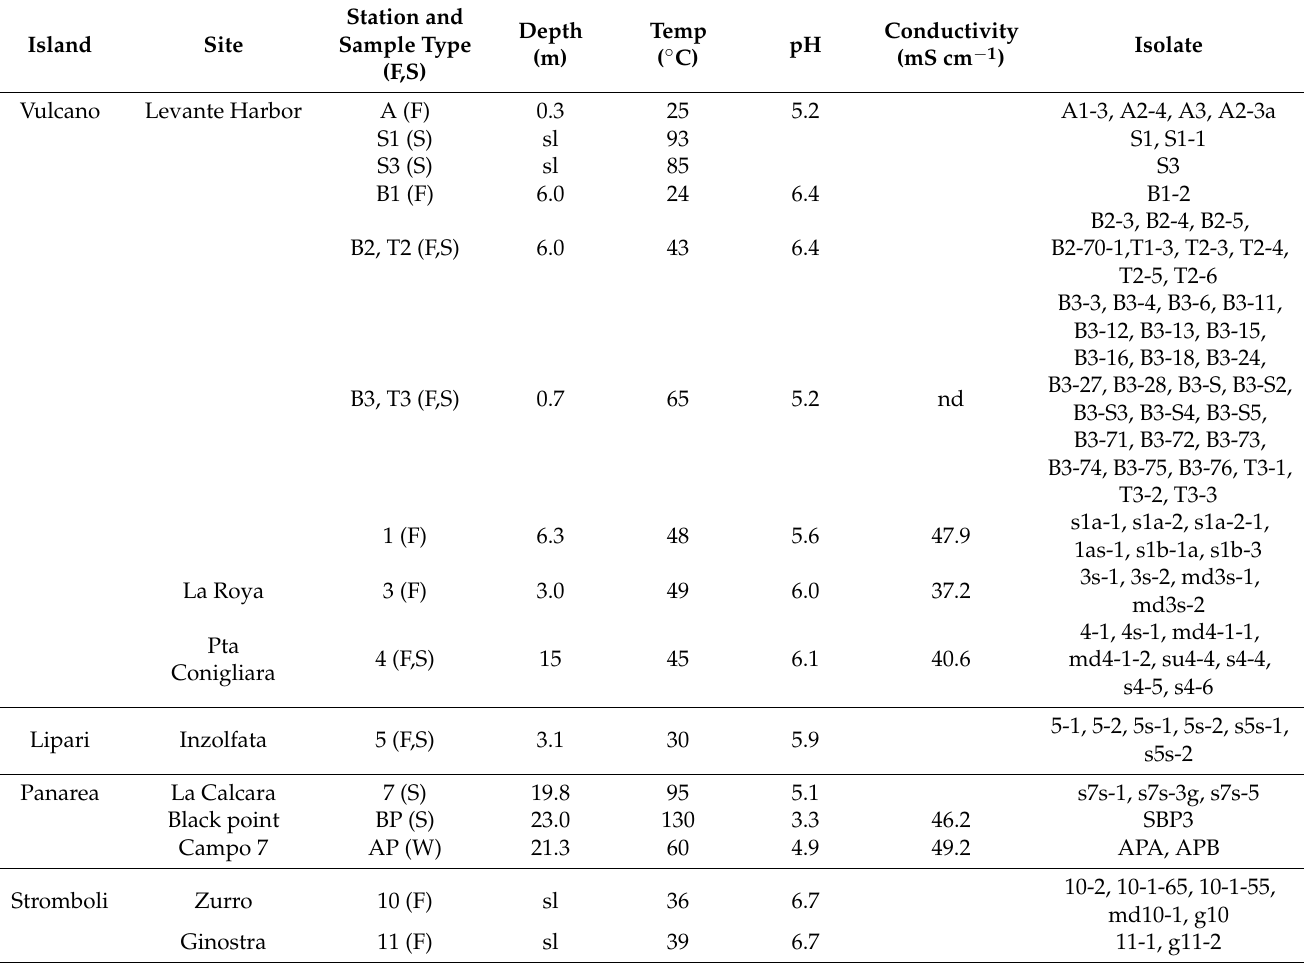
Table 1. Characteristics of fluid (F) and sediment (S) samples collected from the hydrothermal vents of Eolian Islands (Italy), and designation of the 80